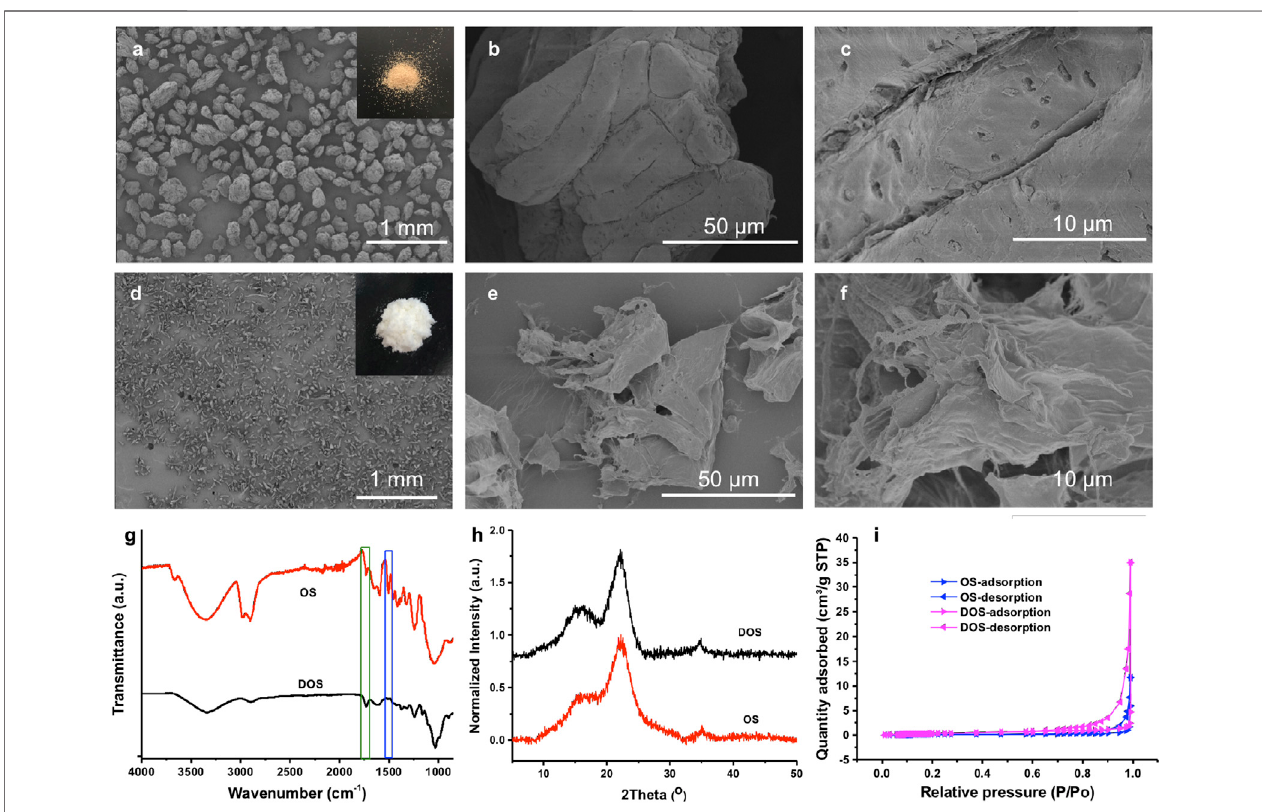
FIGURE 2 | SEM images of original olive stone powder (A – C) , and deligni fi ed olive stone powder (D – F) . Inset images in (A) and (D) are photos of original stone powder and deligni fi ed olive stone powder respectively. (G – I) are the FTIR spectra, XRD spectra, and nitrogen adsorption-desorption isotherms of original olive stone powder (OS) and deligni fi ed olive stone powder (DOS)